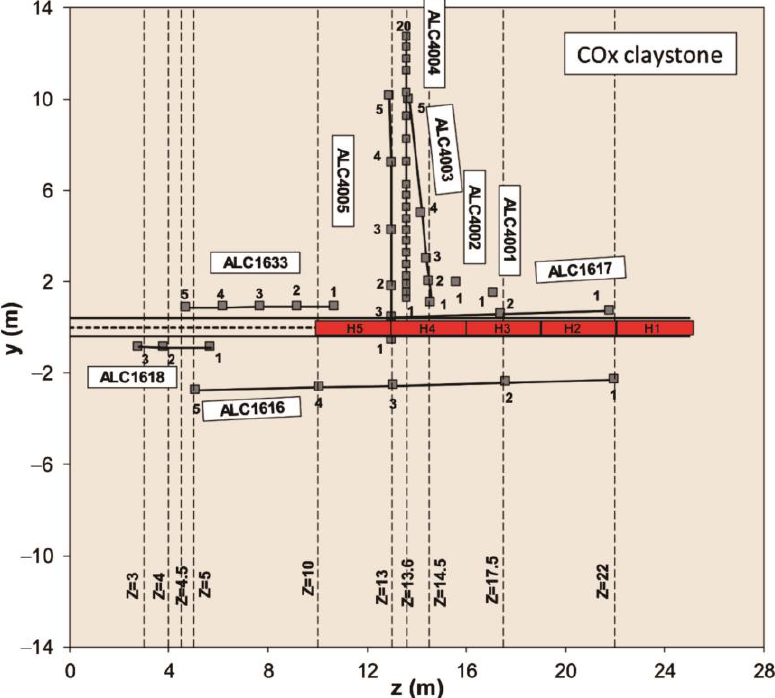
Figure 3. Locations of monitor boreholes and observation points around the ALC1604 cell. Reprinted from [5] with permission from Elsevier.